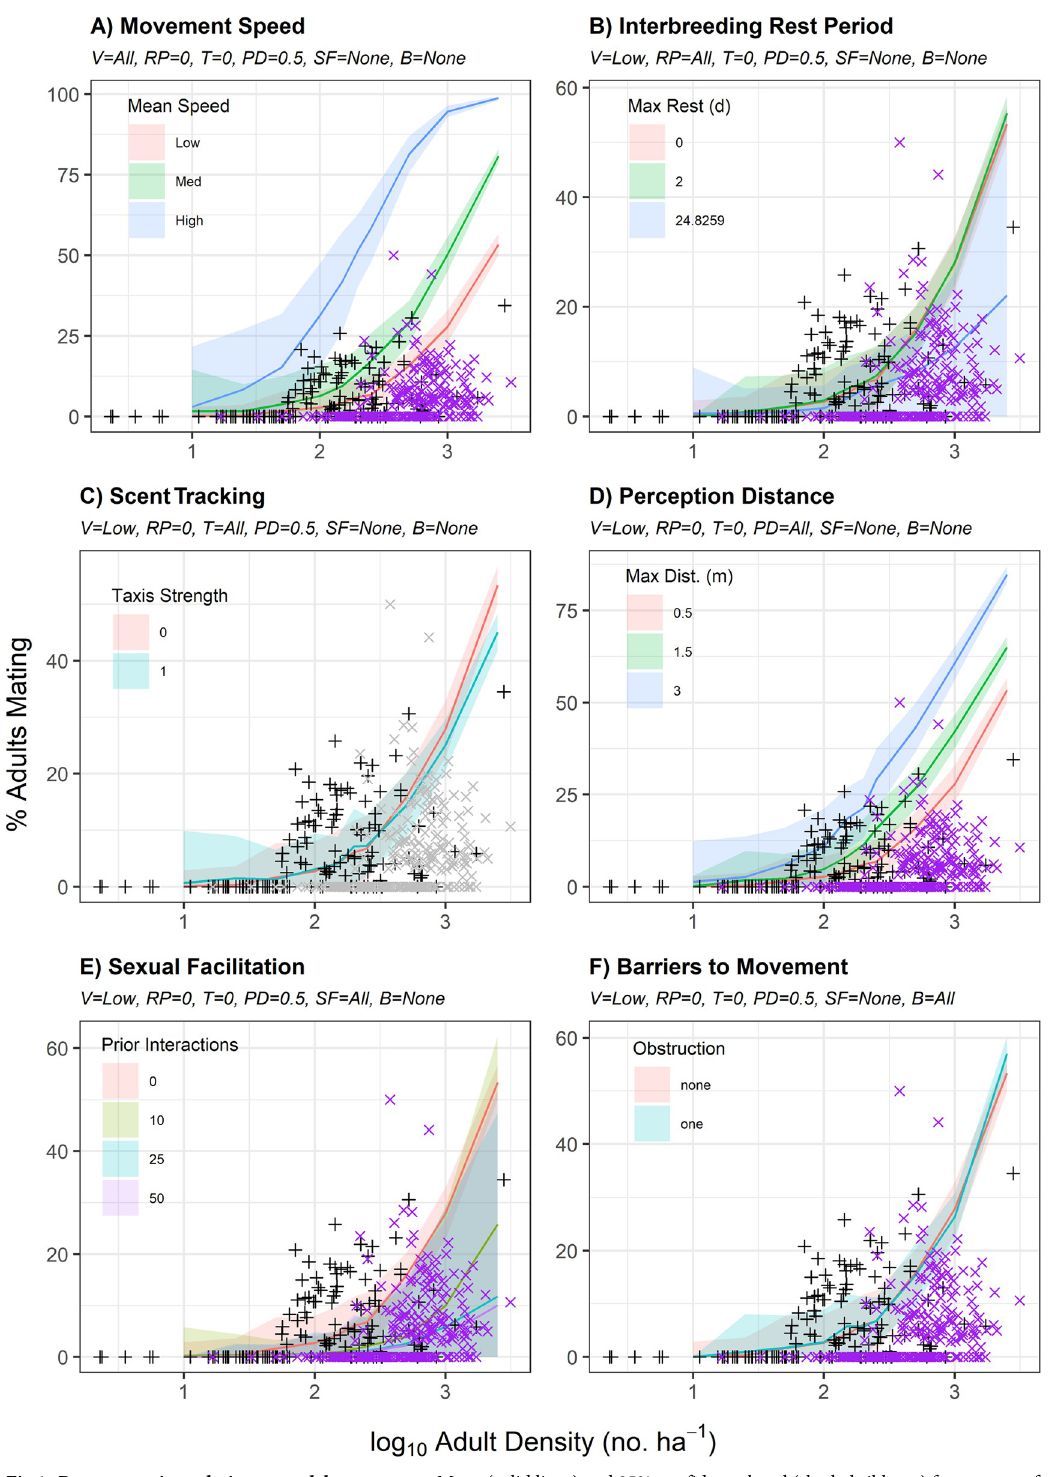
Fig 1. Percent mating relative to model parameters. Mean (solid lines) and 95% confidence band (shaded ribbons) for percent of simulated adult queen conch successfully mating relative to log 10 adult density (No./ha) relative to variation in A) movement speed (V), B) interbreeding rest period (RP), C) scent tracking (T), D) perception distance (PD), E) sexual facilitation (SF), and F) barriers to movement (B), with all other variables fixed at their lowest simulated values. Empirical observations by Stoner & Ray- Culp [32] and Stoner et al. [34] (black crosses) and Delgado & Glazer [38] (purple x’s) are overlaid for comparison.